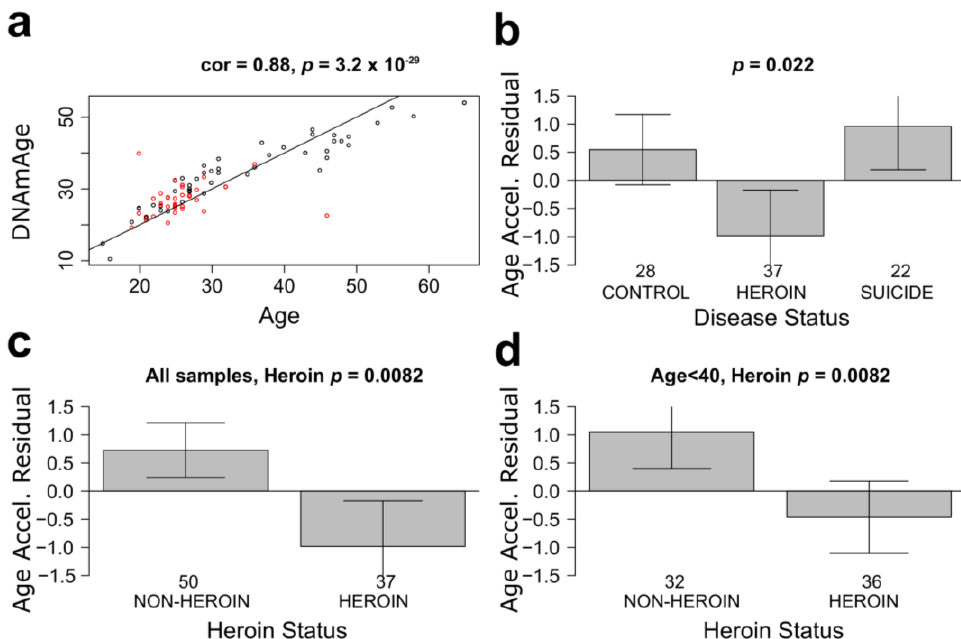
Figure 1. Neurons of heroin users show younger epigenetic age than neurons of non-addicted individuals. ( a ) Correlation of neuronal DNAm age with chronological age of all subjects at time of death. Red circles, heroin subjects; black circles, all other subjects; ( b ) Analysis of epigenetic age acceleration in the neurons among heroin users, suicide subjects, and controls. The heroin subjects have a younger DNAm vs. chronological age ( p = 0.022); ( c ) Analysis of epigenetic age acceleration in the neurons comparing heroin users and all subjects who did not abuse heroin. A significantly younger neuronal DNAm age in heroin users was observed ( p = 0.0082); ( d ) Same as in ( c ), but for subjects with chronological age <40. The titles of the bar plots report the results of a non-parametric group comparison test (Kruskal Wallis test).